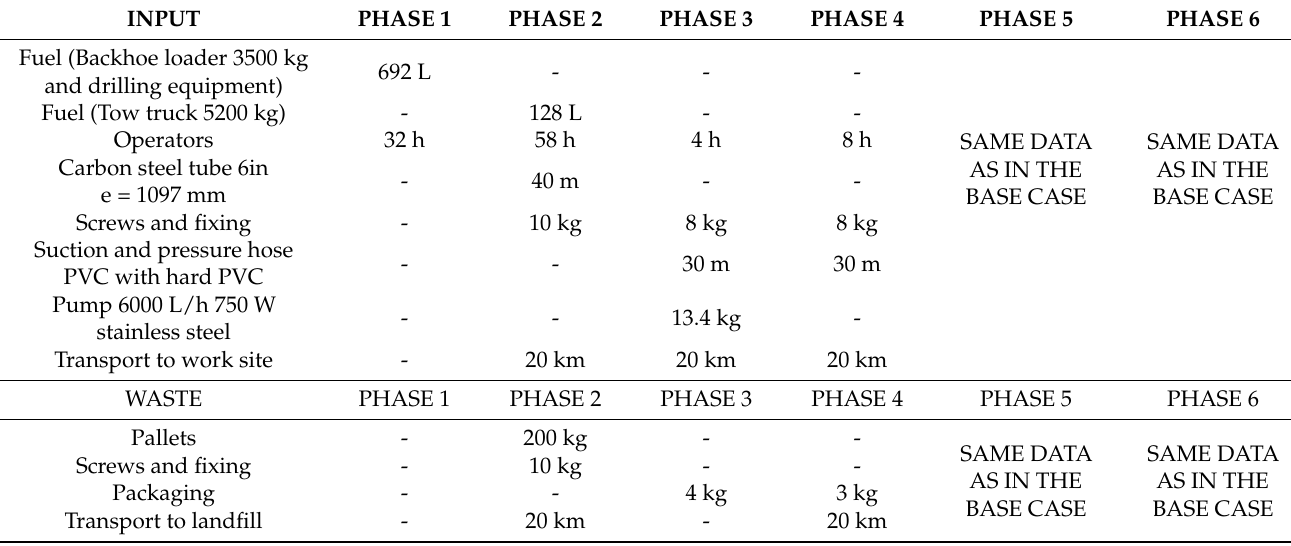
Table 3. Alternative C